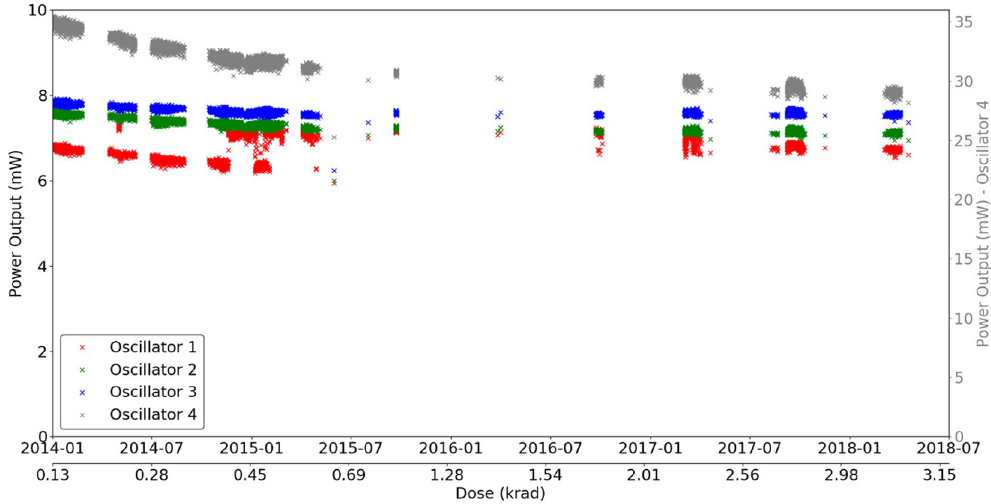
Figure 9. Power output of all oscillators as a function of time and dose for temperatures between 22 and 25 °C. Only Oscillator 4 shows a significant decrease in power output. (In this case, the transistors have not gone through a combined thermal/electrical aging process, so it is expected that the first part of the graph corresponds to a burn-in